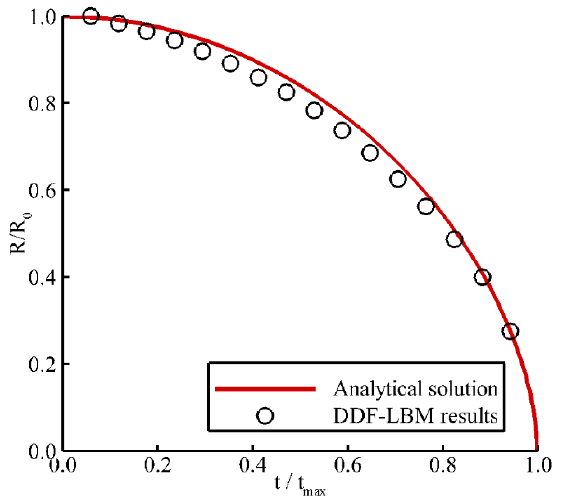
Figure 1. Comparison of the radius evolution between analytical solution and the results by DDF- LBM model.